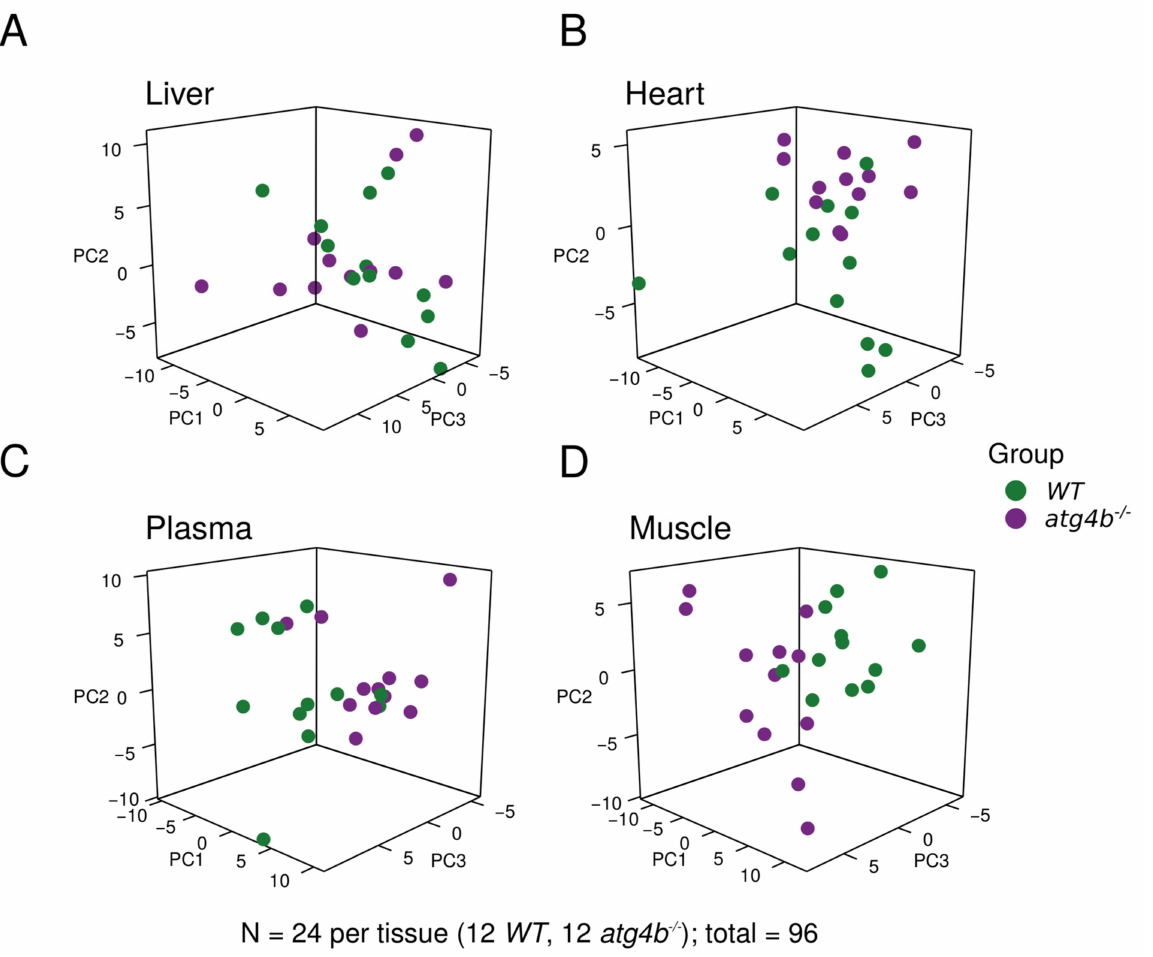
Figure 1. Metabolomic profiling of autophagy-deficient mouse tissues. Principal component analysis plots showing the distribution of WT and atg4b − / − samples in liver ( A ), heart ( B ), plasma ( C ), and skeletal muscle tissue ( D ) across the first three principal